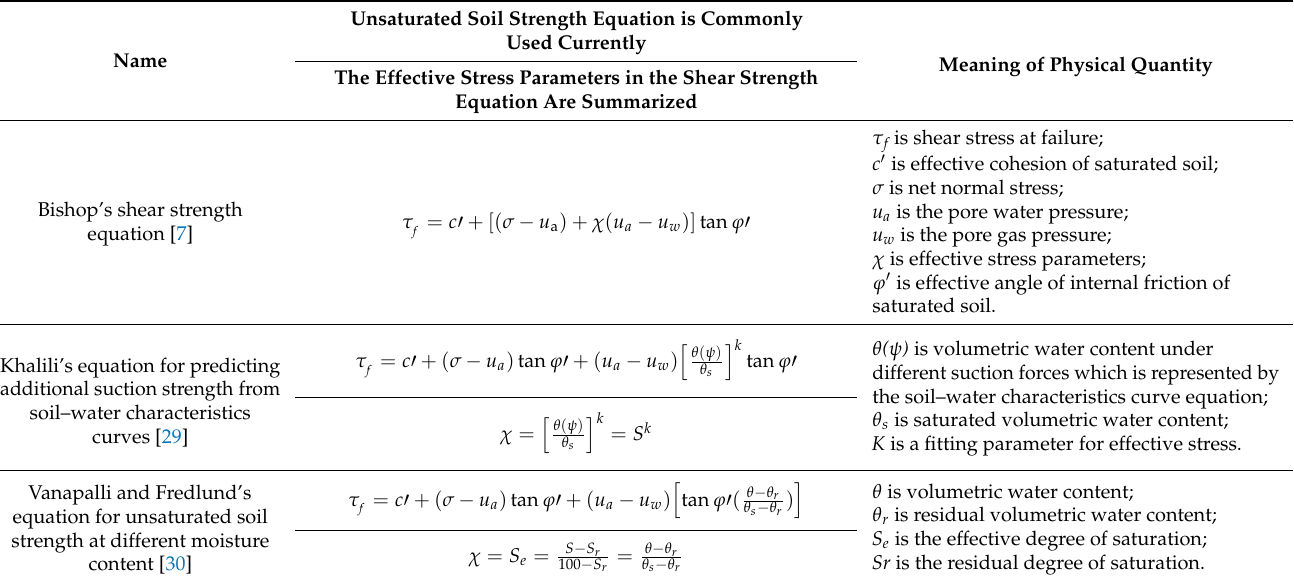
Table 4. Commonly used unsaturated soil strength equation.